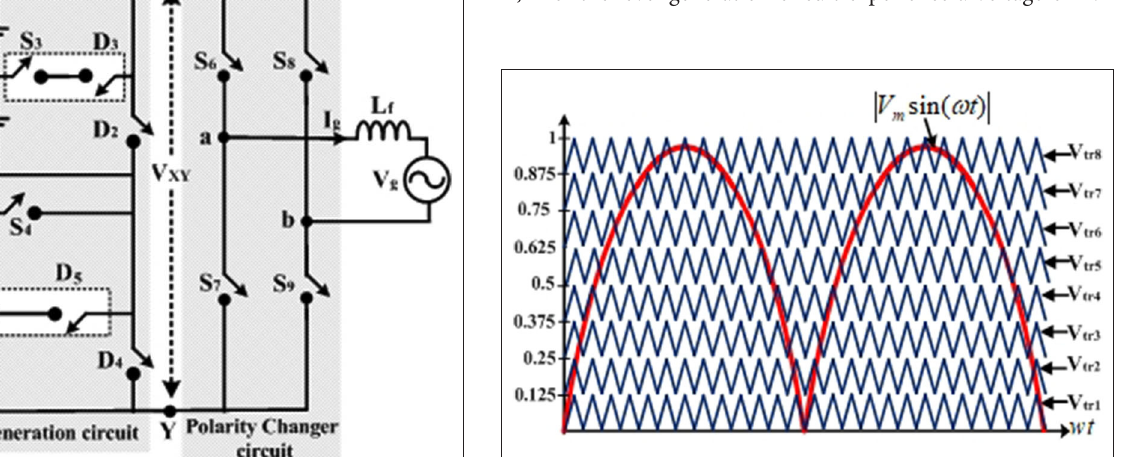
FIGURE 4 | The proposed Bi-directional seventeen level inverter topology.